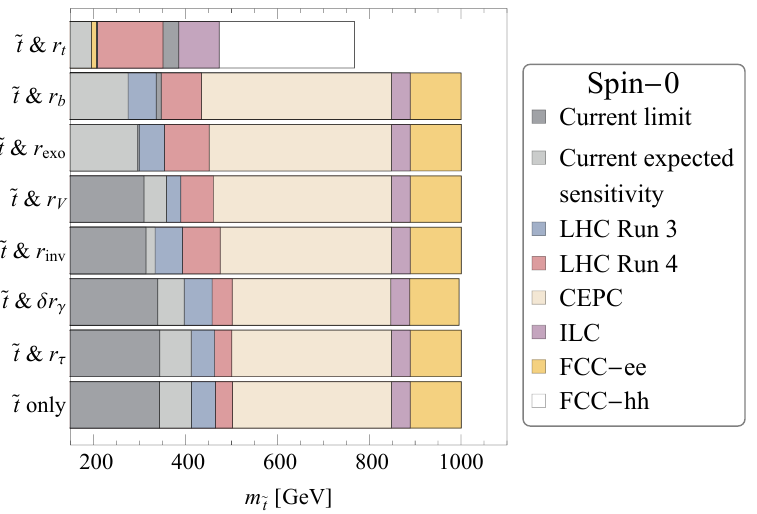
Figure 5 . Excluded parameter space and expected sensitivities at the 2 (cid:27) C.L. on degenerate spin-0 (cid:17) m top partner masses, m ~ = m ~ ~ t , from various joint-(cid:12)ts of current and future data. We assume t 1 t 2